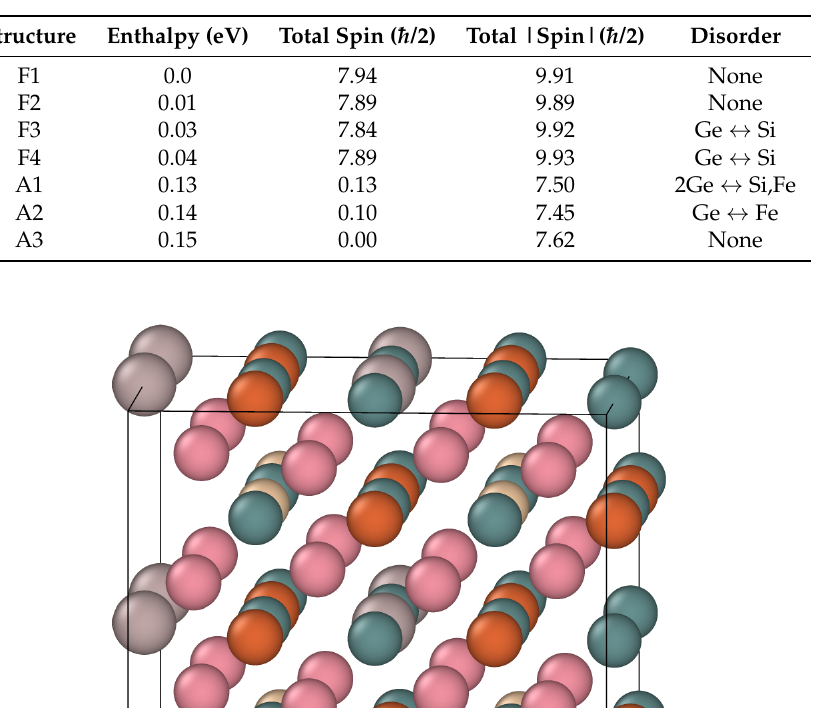
permutations in relation to F1.